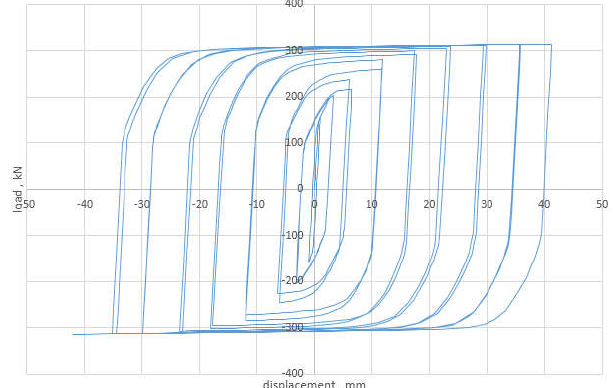
Figure 4. Force–displacement plot for finite element model.